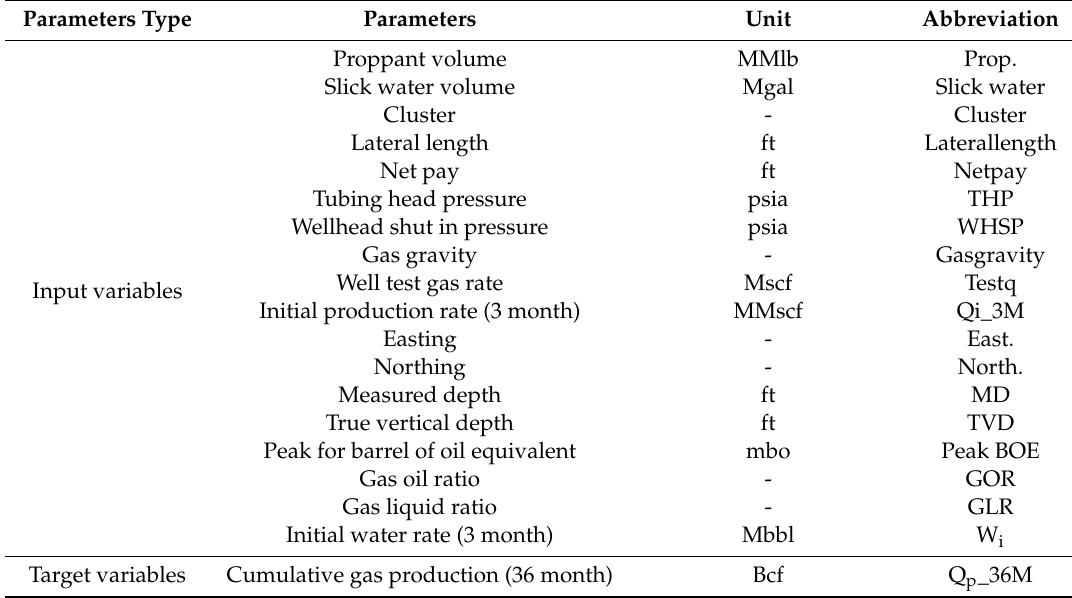
Table 1. Parameters and abbreviation for input and target variables used in this study.